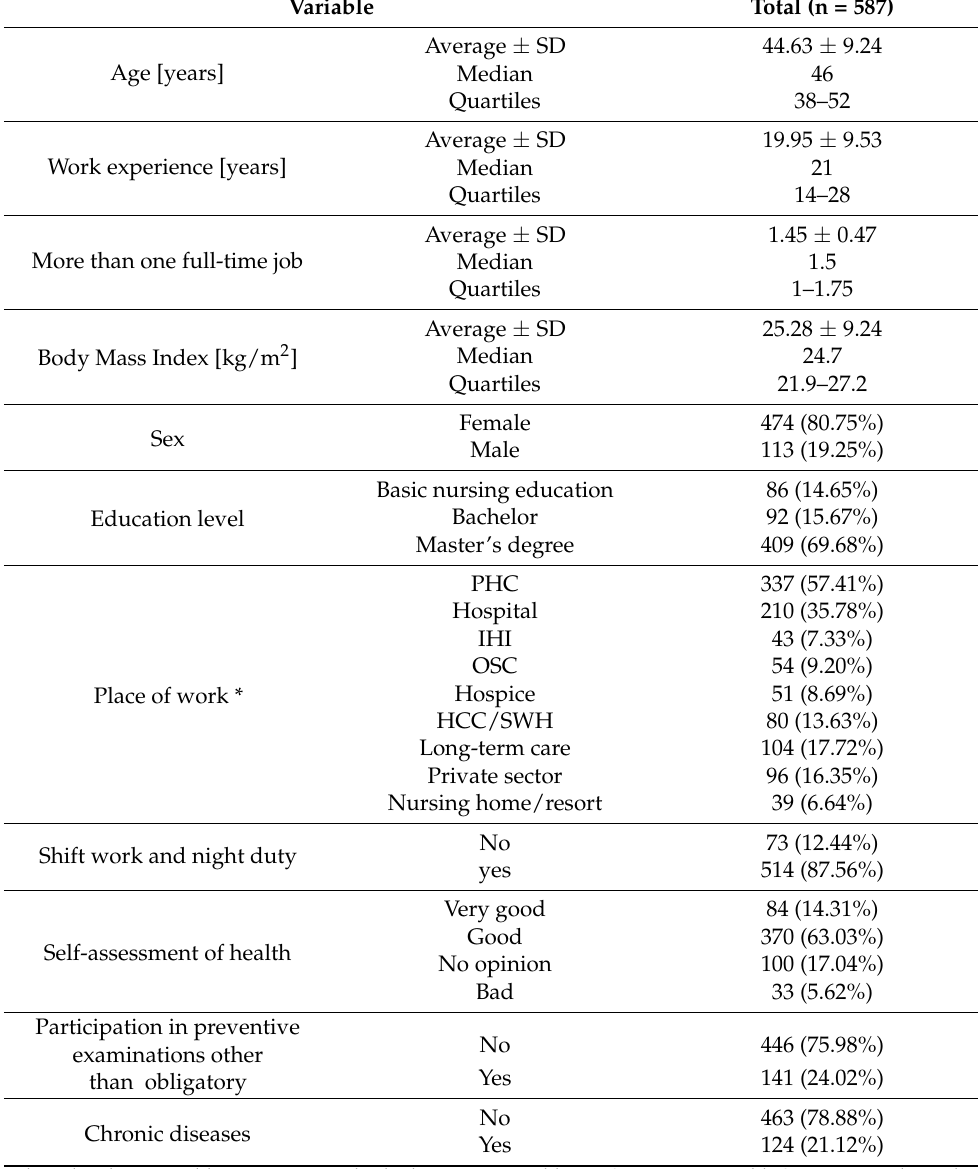
Table 1. Characteristics of the study group.